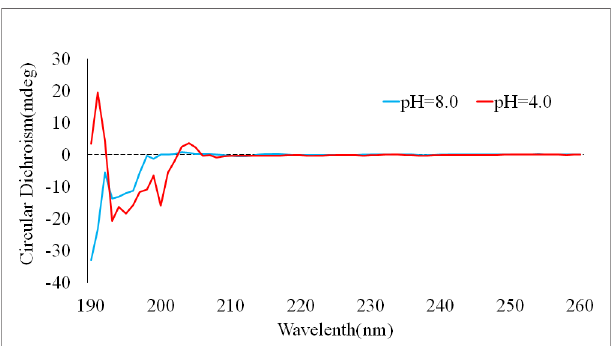
FIGURE 1 | Circular dichroism of pHLIP (var7) at pH 4.0 (red line) and pH 8.0 (blue